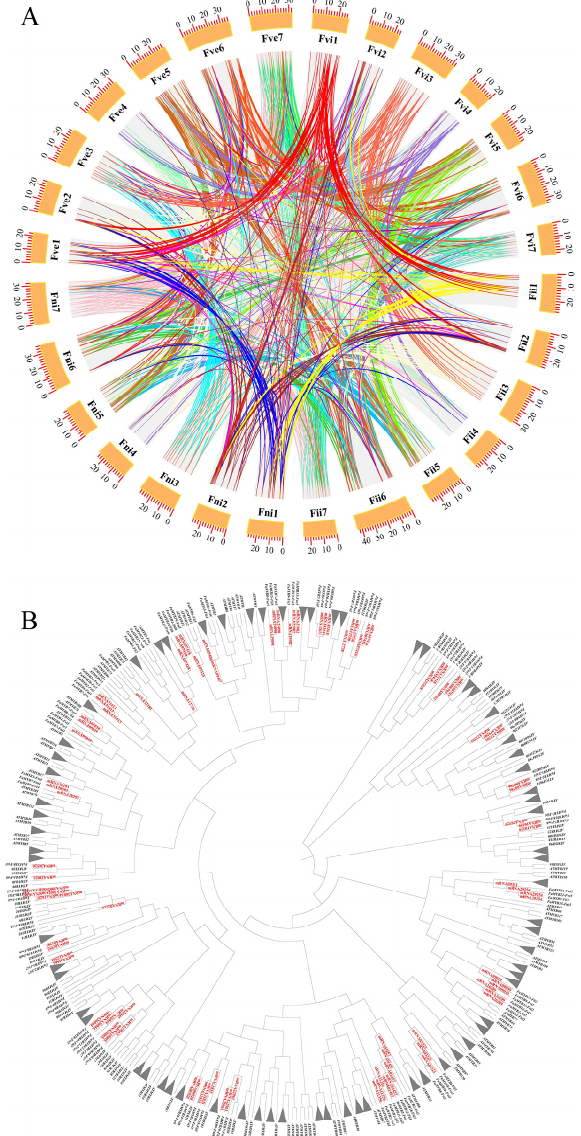
Figure 2. The FaMYB locus identification. ( A ) The synteny analysis of the F. ananassa genome. Syntenic blocks are linked by dark lines and FaMYB gene pairs are highlighted by different colors. The sub-genomes are labelled by Fve, Fii, Fni and Fvi according to sub-genome donors, respectively [33]. FaMYB loci are located on the scale plate of the chromosomal length in megabases (Mb). ( B ) The FaMYB locus illustration by neighbor–join phylogeny of FaMYBs and AtMYBs. The MYBs of F. vesca (FvMYBs) on branches indicated the loci names. The collapsed nodes are FaMYB loci including at least one allele of each homologous chromosome and loci name are shown in Table S6.